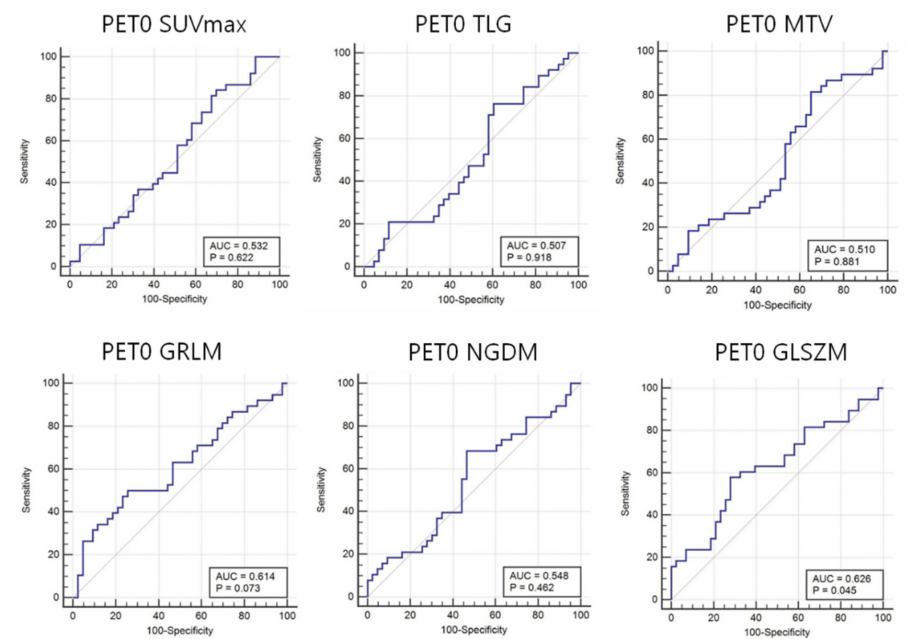
Figure 4. Area under the receiver operating characteristic curves (AUC) for 18 F-FDG heterogeneity features in baseline PET0. Conventional parameters (i.e., maximum standardized uptake value (SUVmax), total lesion glycolysis (TLG), and metabolic tumor volume (MTV)), cannot predict the response to neoadjuvant chemotherapy before treatment. In contrast, the 18 F-FDG intensity size zone feature (gray-level size zone matrix: GLSZM) heterogeneity can predict this response.